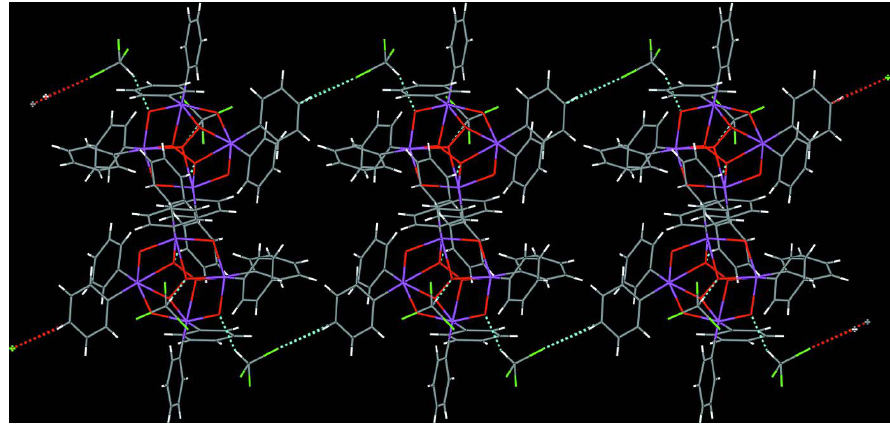
Infinite strands formed in the crystal structure of the title compound, viewed along [1 0 0]. For details about contacts